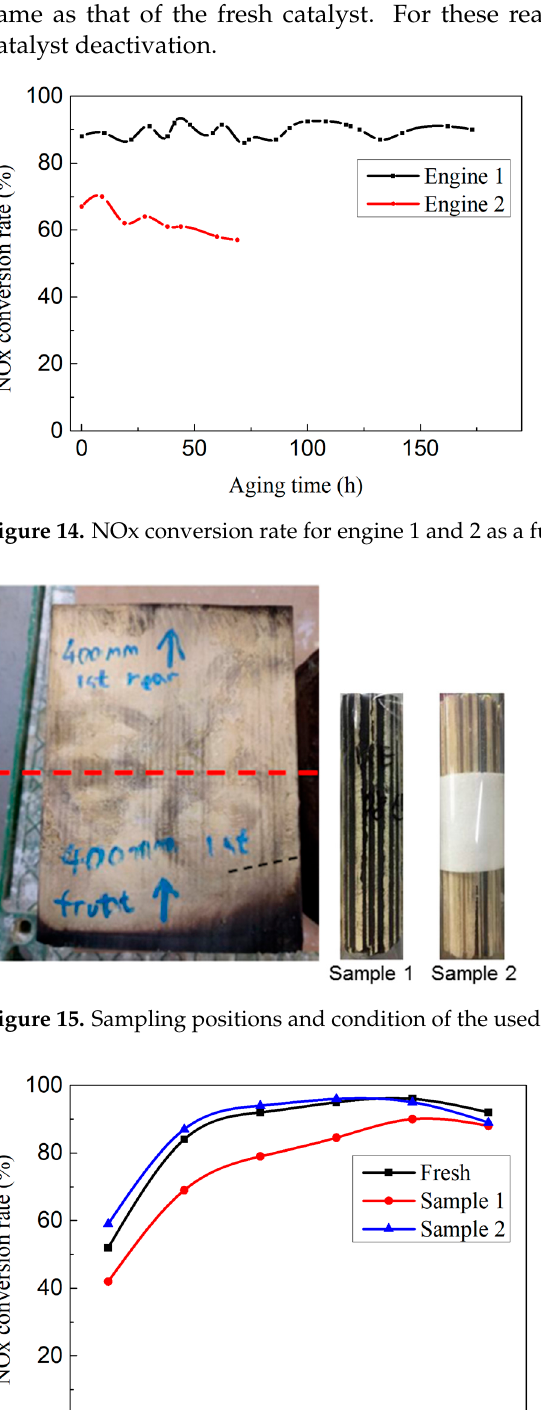
Figure 15. Sampling positions and condition of the used catalyst before and after regeneration.